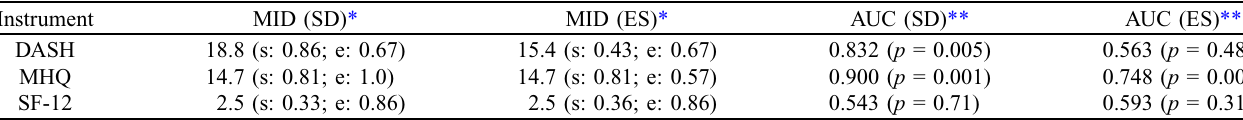
Table 4. MID Calculations – analysis derived from baseline and 3-month assessment.